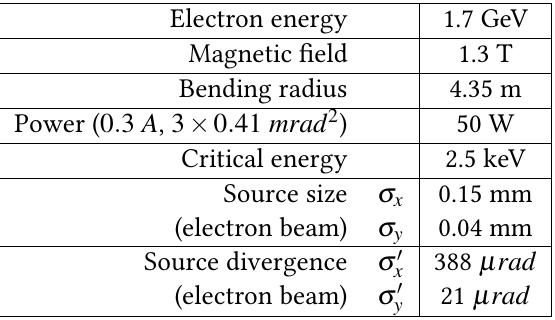
Table 1: Properties of the Dipole D 13.1 source.